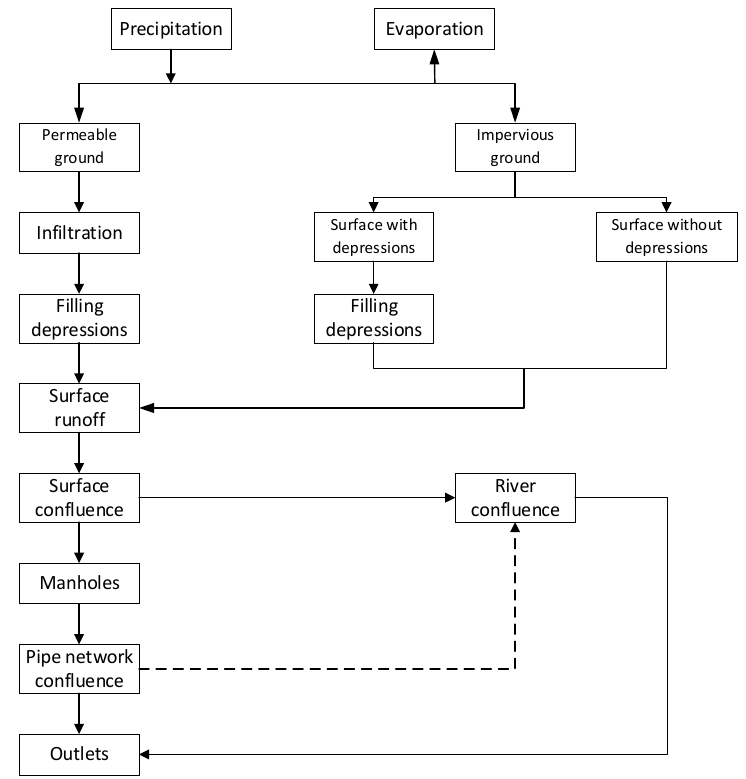
Figure 1. The schematic diagram of the basic flow of urban production and confluence.